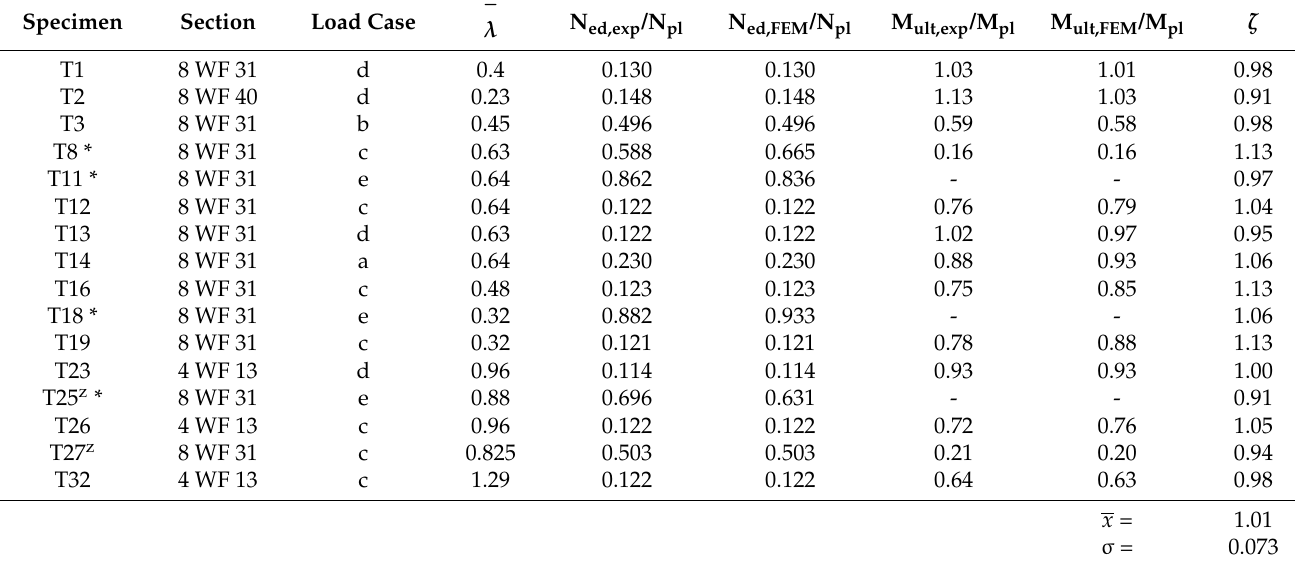
Table 1. Comparison of ultimate resistance of beam-columns determined by numerical and experimental analysis.